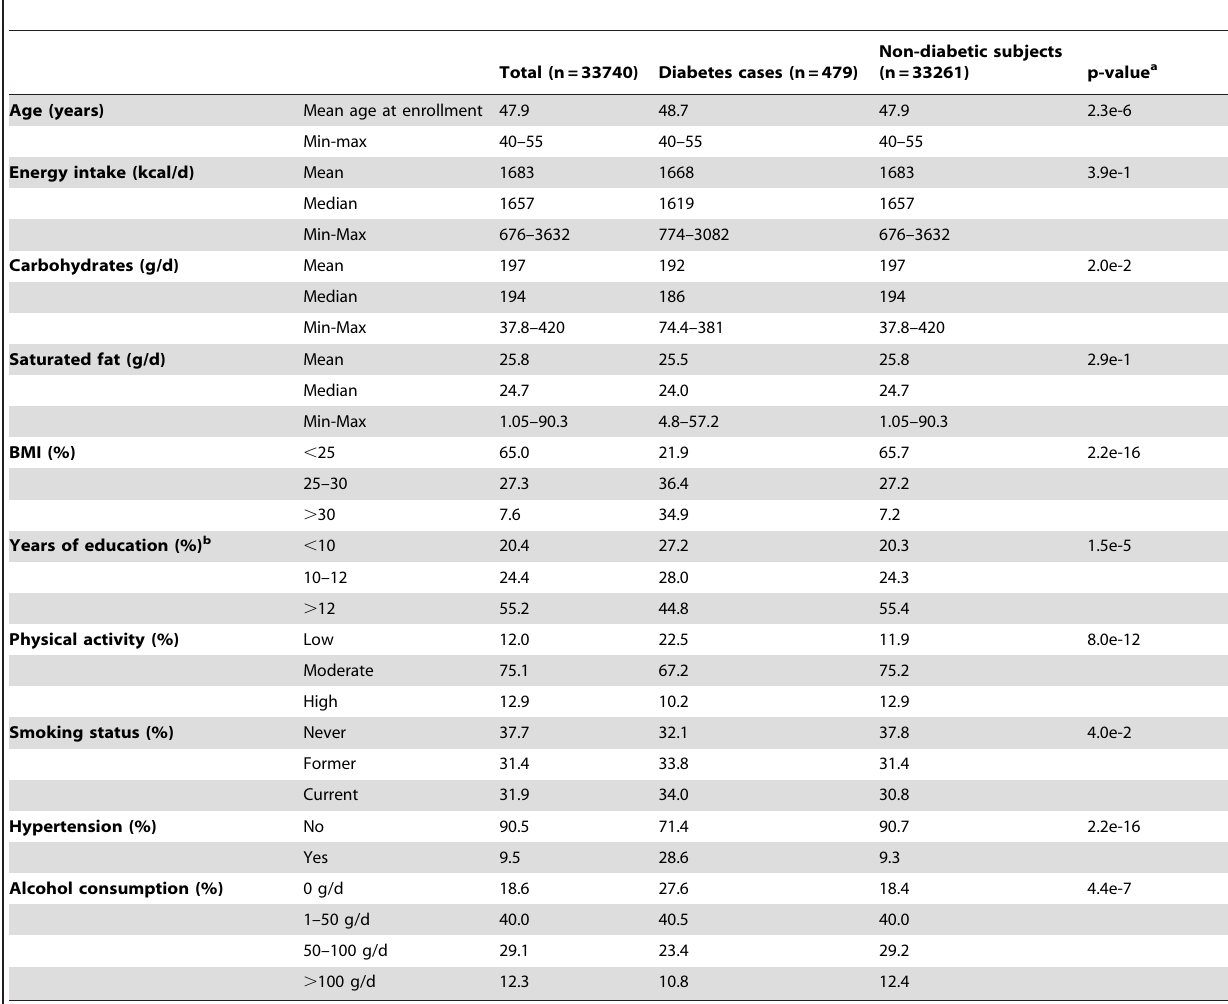
Table 1. Self-reported baseline characteristics of the total study population (n =33740), the incident diabetes cases (n=479) and the non-diabetic subjects